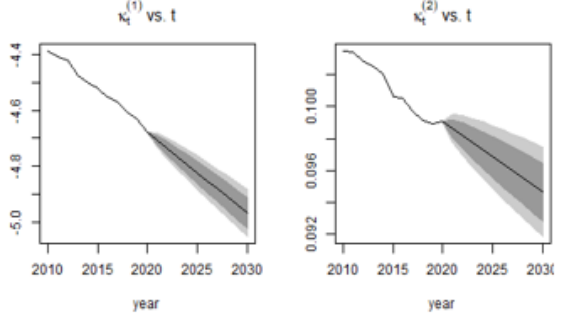
Figure 13. Parameter Forecast using the Cairns–Blake–Dowd model.